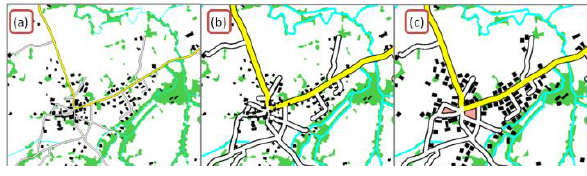
Figure 4. (a) initial data at 1:15k with a symbols scaled to 1:15k. (b) same data with symbols scaled to 1:25k. (c) data generalized to 1:25k